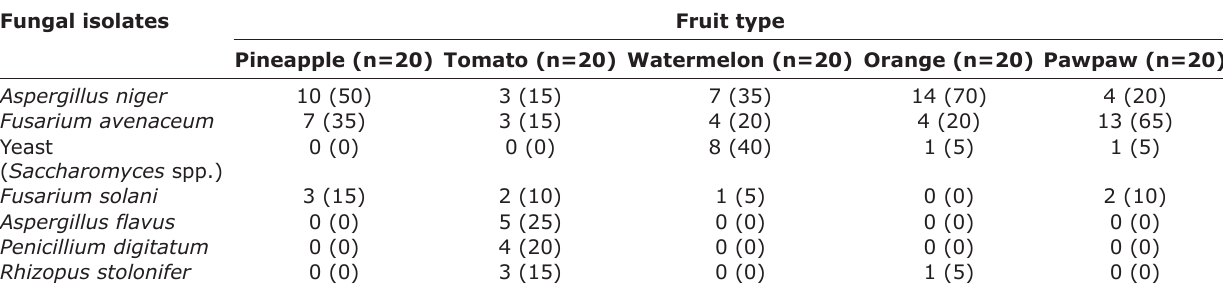
Table-2: Prevalence and distribution of fungi associated with spoilt fruits vended in Gwagwalada. Fungal isolates Fruit